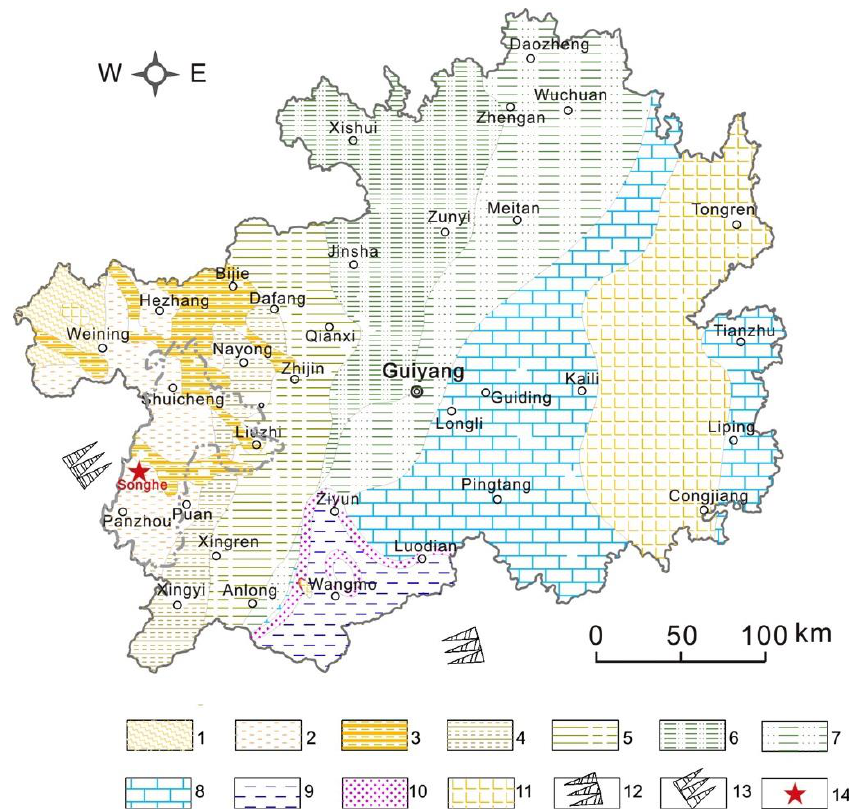
Figure 1. Late Permian paleogeography of Guizhou Province, Southwestern China (modified from Guizhou Bureau of Geology and Mineral Exploration, 1987 [31]). 1—river; 2—river dominated upper delta plain; 3—distributary channel; 4—transitional delta (interdistributary bay); 5—tide dominated lower delta plain; 6—tidal flat and lagoon; 7—restricted platform; 8—open platform; 9—deep basin; 10—reef limestone; 11—upland; 12—terrigenous direction; 13—transgression direction; 14— sampling location.